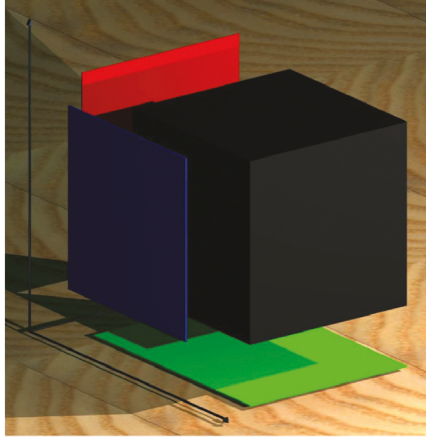
Figure 3: Decomposition D .